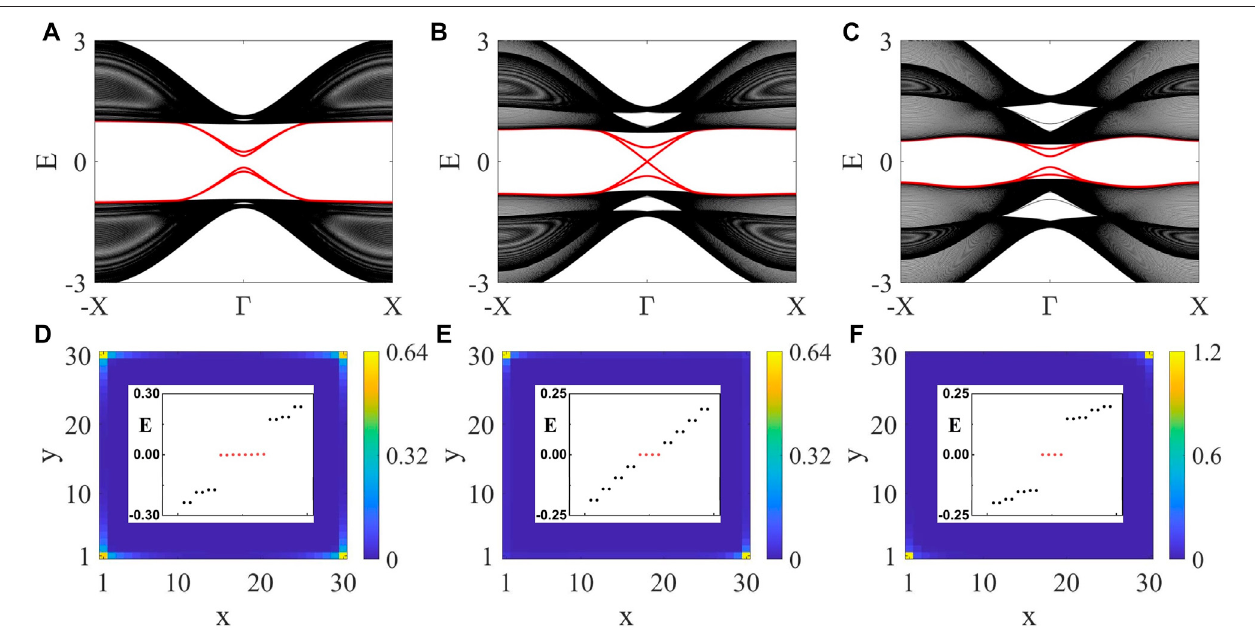
FIGURE3| (Coloronline)Boundarytopologicalphasetransitionsinducedbyanin-planeferromagnetic-typeZeeman fi eld.Chosenparametersare: t =1, m =1, λ = 1, η =0.2.Forthechosensetofparameters,thecriticalvaluefortheboundarytopologicalphasetransitionis B c (cid:2) | η ~ m / t | (cid:2) 0 . 2.In (A) and (D) , B x = B y =0.05.Asboth B x and B y are smaller than B c , the eight zero-energy corner states remain robust (the observable energy splitting for four corner states originates from the enhancement of fi nite-size effects as a result of the decrease in the boundary energy gap). In (B) and (E) , B x = B y = 0.2, the boundary energy spectrum becomes gapless at this critical point. In (C) and (F) , B x = − B y = 0.4. The boundary spectrum becomes gapped again, but the number of zero-energy bound states is reduced by half, indicating therealizationofanewSOTIphase.In (A – C) ,periodicandopenboundaryconditionsareconsideredinthe x and y directions,respectively,with N y =100.In (D – F) ,both x and y directions take open boundary